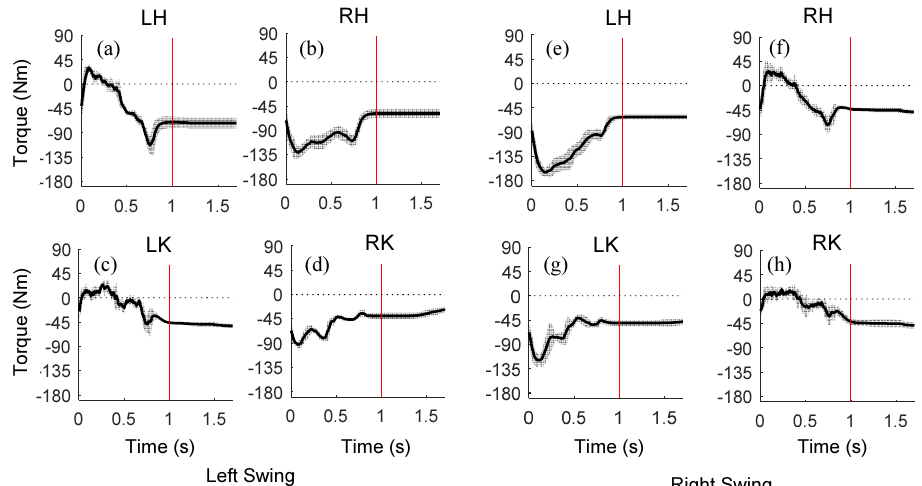
Figure 12. Actuation torque of each joint for one gait cycle. Positive values represent joint flexion torques, and negative values represent joint extension torques. LH, LK, RH and RK stand for the left hip, left knee, right hip and right knee joints, respectively.